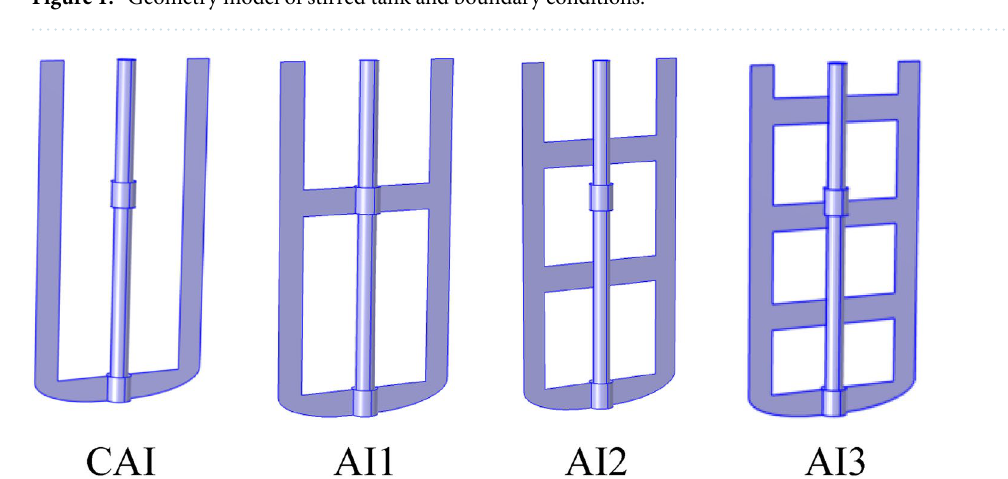
Figure 1. Geometry model of stirred tank and boundary conditions.